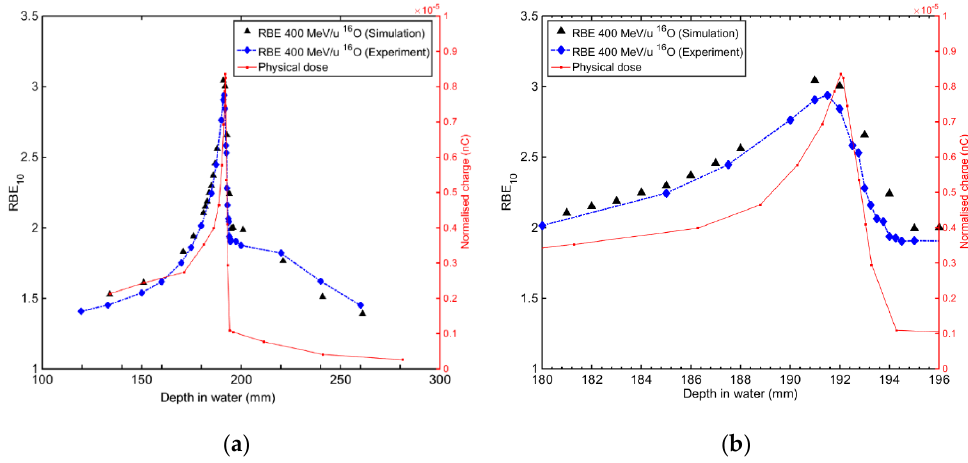
Figure 15. ( a ) RBE 10 distribution obtained with the MicroPlus Mushroom microdosimeters versus depth in water for the 400 MeV/u 16 O pristine BP, ( b ) zoomed-in view of RBE 10 distribution [32].